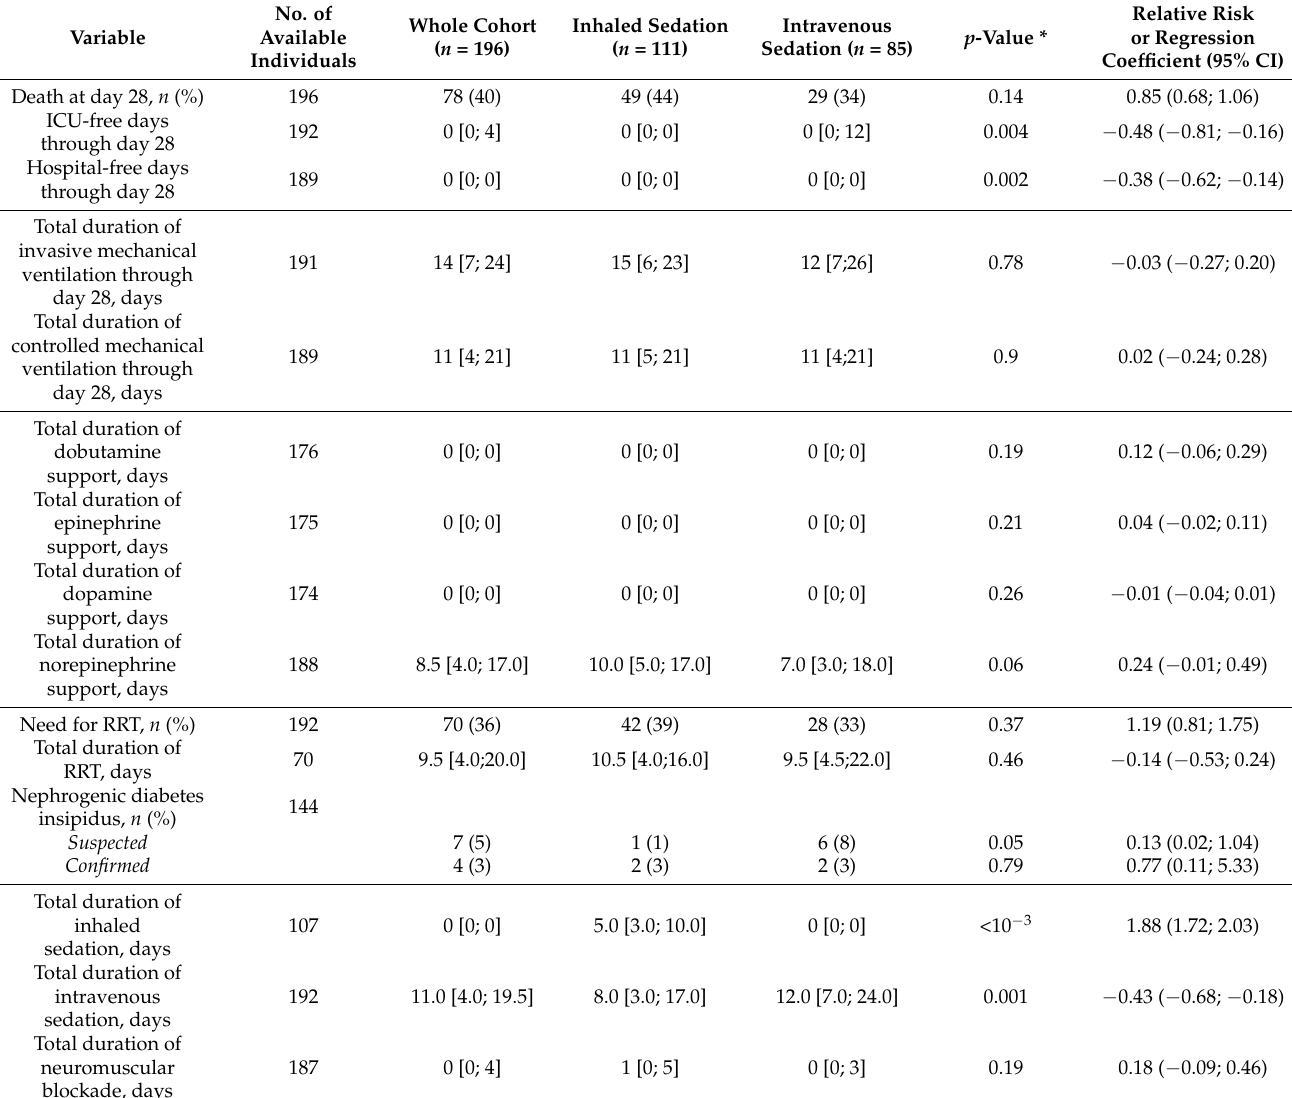
Table 4. Secondary endpoints as evaluated at day 28 after